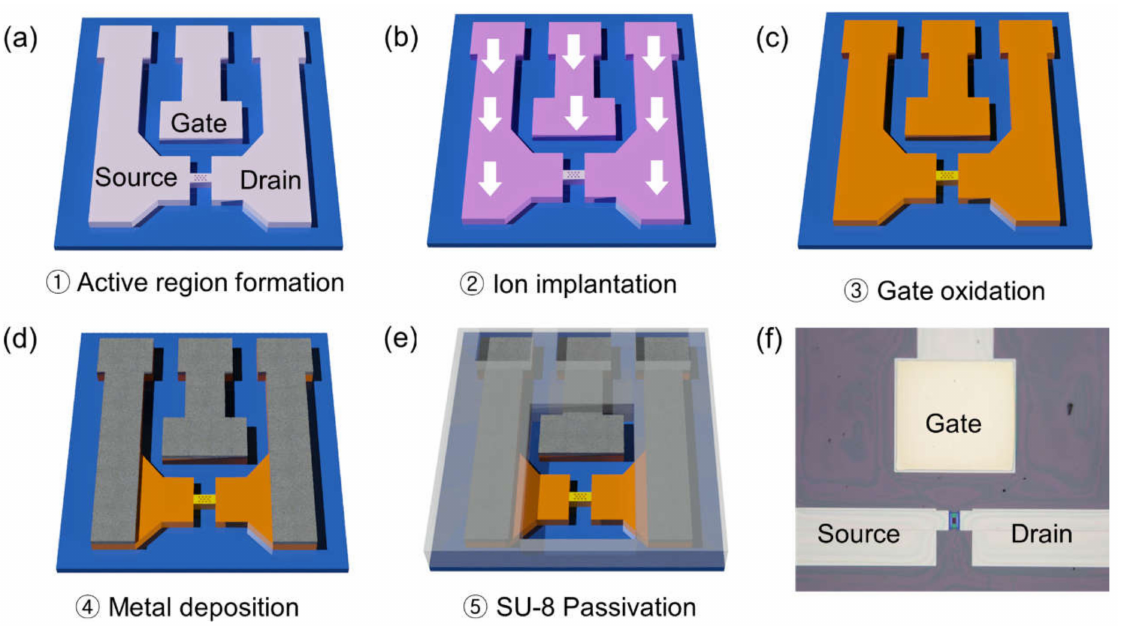
Figure 1. ( a – e ) Schematics of fabrication flow and ( f ) an optical image of the top view of the fabricated Si-EGT.